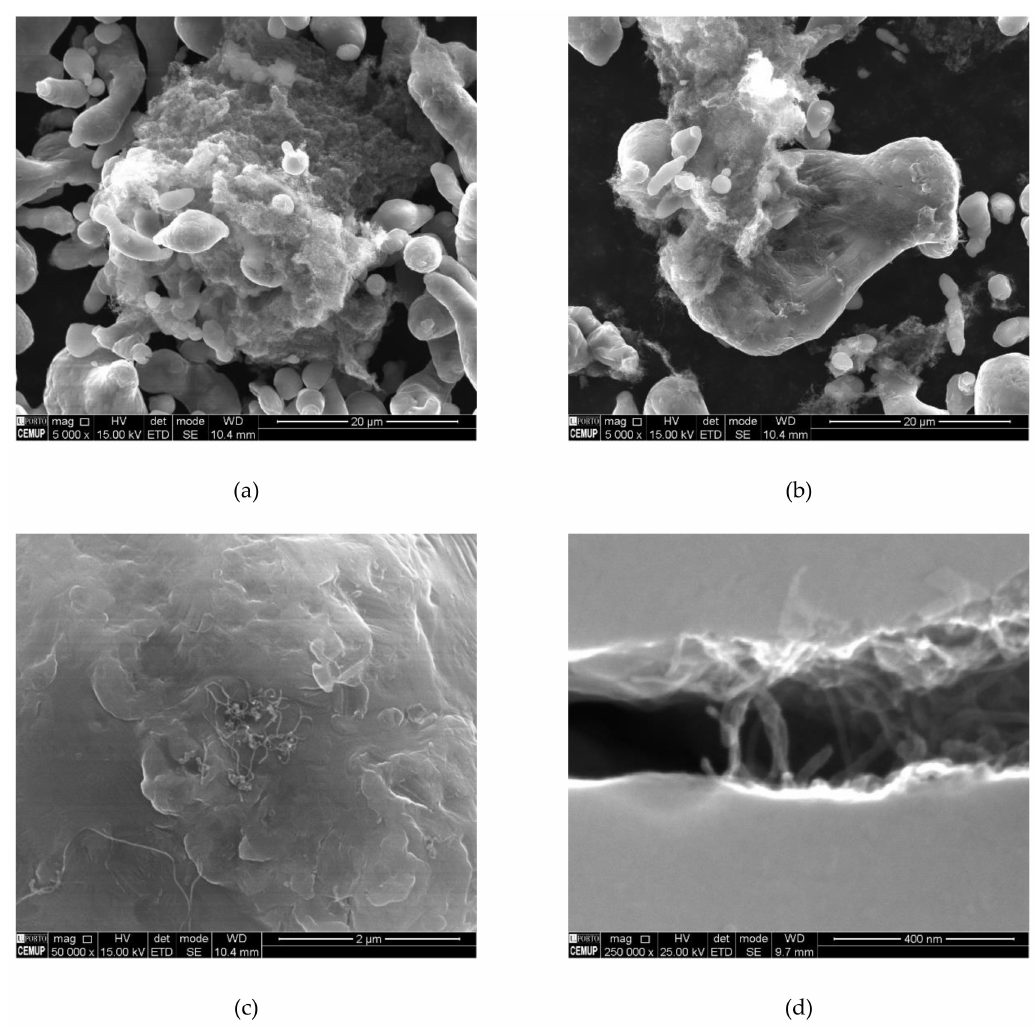
Figure 2. SEM/SE images of Al-0.75 wt. % MWCNT: ( a ), ( b ), and ( c ) dispersion of the constituents before compaction; and ( d ) cross section of the sintered specimen at the end of a prolonged crack in a hardness indentation